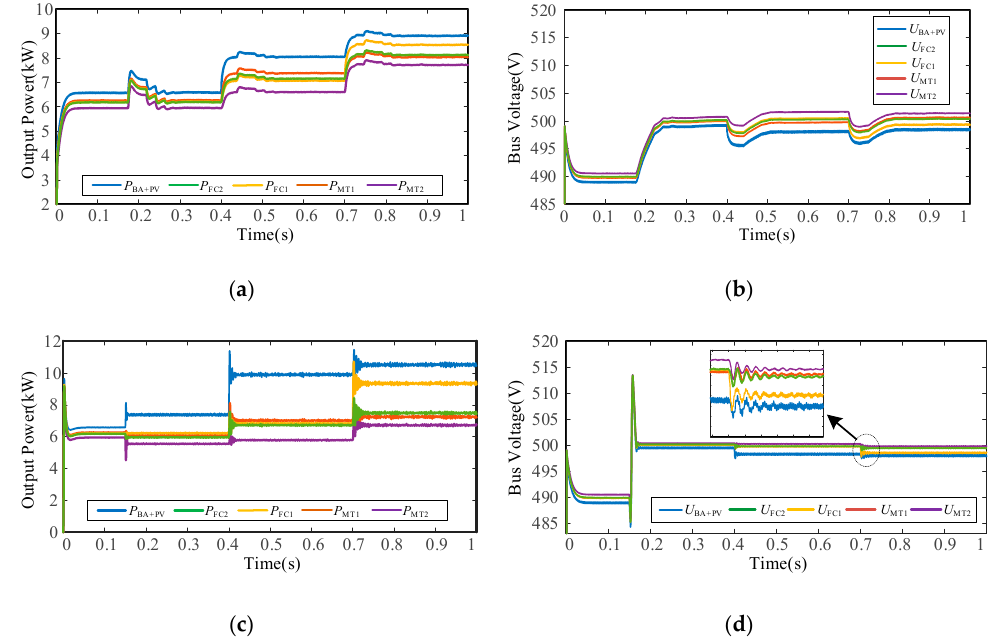
where U ref and U oi* are the system reference voltage and voltage command of the converter respectively. C i is the cost of DG i while C NL , i is the cost in no-load situation. χ is a constant decided by the capacity of the converter. From (45), it can be inferred that the costs of DGs will converge to the Figure 10. The comparison between the proposed distributed control and the decentralized control in Figure 10. The comparison between the proposed distributed control and the decentralized control secondary level. ( a ) the output power of each generator based on the proposed scheme; ( b ) the bus same value in steady state. It means that the outputs of high-cost generators are less, while that of in secondary level. ( a ) the output power of each generator based on the proposed scheme; ( b ) the voltages based on the proposed scheme; ( c ) the output power of each generator based on the low-cost generators are more instead of equal sharing. Figure 11 shows the results of the two control bus voltages based on the proposed scheme; ( c ) the output power of each generator based on the decentralized scheme; ( d ) the bus voltages based on the decentralized scheme. schemes. decentralized scheme; ( d ) the bus voltages based on the decentralized scheme.